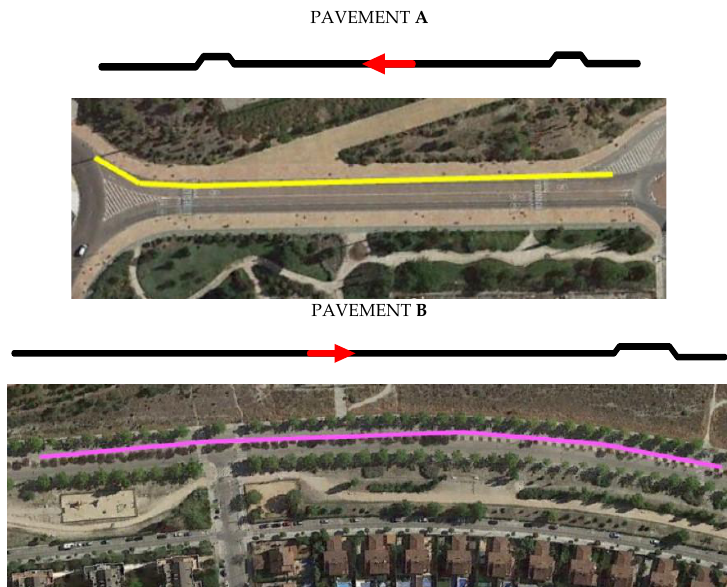
Figure 6. Route on pavements A ( ~ 225 m) and B ( ~ 380 m).